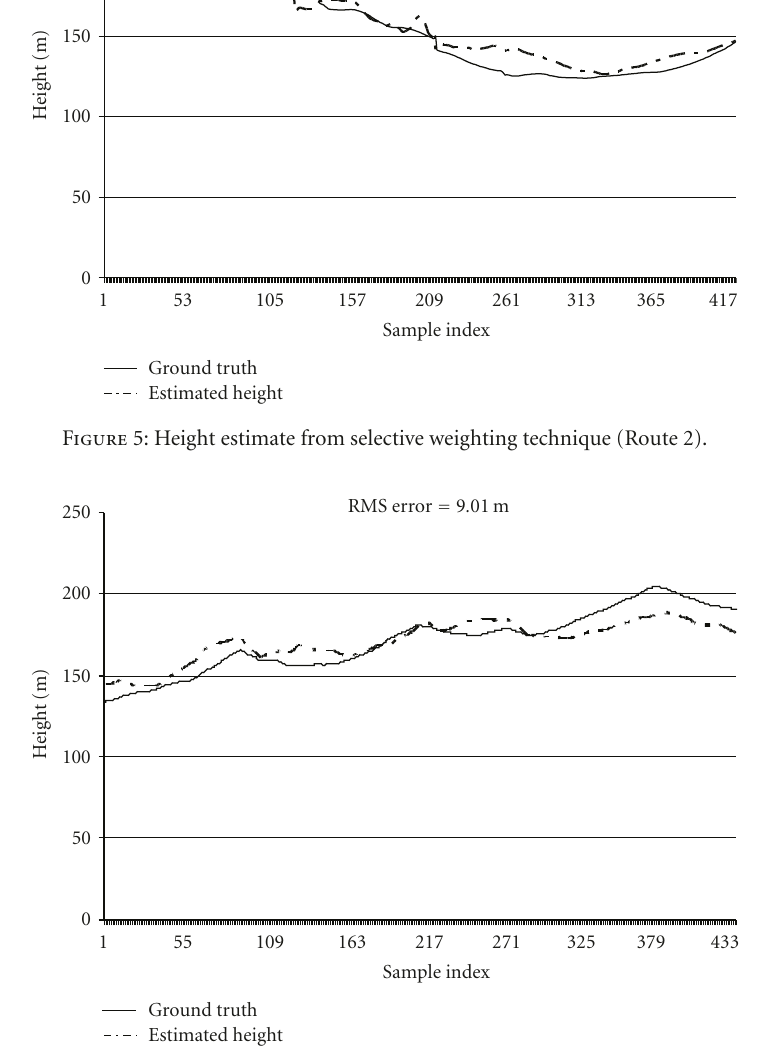
Figure 6: Height estimate from selective weighting technique (Route